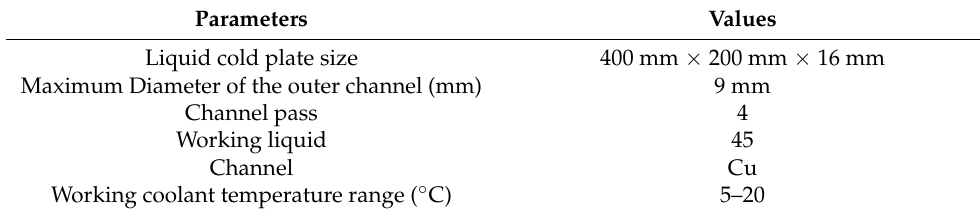
Table 5. Specifications of the liquid cold plate.